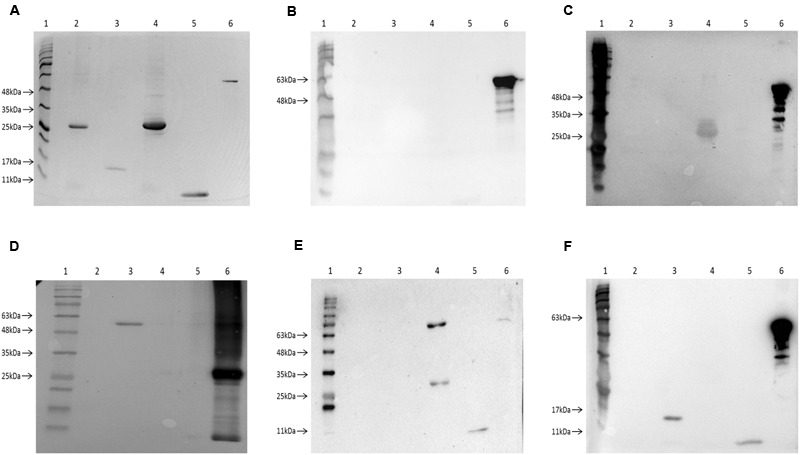
Investigation of the Exs protein interactions using Far-Western Blot. (A) A 12% SDS-PAGE gel showing the purified Exs proteins and a MBP-fused Exs protein as positive control for Far-Western Blot. Lane 1, BLUeye Prestained Protein Ladder (Geneflow); Lane 2, purified HisExsA protein (∼33 kDa); Lane 3, purified HisExsC protein (∼18.5 kDa); Lane 4, purified HisExsD protein (∼33 kDa); Lane 5, purified HisExsE protein (∼11 kDa); Lane 6, purified MBP-ExsC protein (∼61 kDa). The proteins on this SDS-PAGE gel were then transferred onto a nitrocellulose membrane for Far-Western Blot. (B) Negative control Far-Western Blot of the control protein MBP5 probing His-tagged Exs proteins. Only MBP-ExsC was observed after probing, suggesting that MBP5 protein without Exs fusions was unable to interact with His-tagged Exs proteins. (C) Far-Western Blot of MBP-ExsA probing His-tagged Exs proteins. The HisExsD protein was detected, suggesting ExsA–ExsD interaction. (D) Far-Western Blot of HisExsD probing MBP-fused Exs proteins. Only MBP-ExsC (∼61 kDa) was detected when probed with HisExsD protein. (E) Far-Western Blot of MBP-ExsC probing His-tagged Exs proteins. The HisExsD and HisExsE proteins were detected, suggesting ExsC–ExsD and ExsC–ExsE interactions. The upper band showing in lane 4 was possibly the size of a dimerized HisExsD (∼66 kDa). (F) Far-Western Blot of MBP-ExsE probing His-tagged Exs proteins. The HisExsC and HisExsE were detected when probed with MBP-ExsE, suggesting ExsE–ExsC interaction and ExsE–ExsE self-interaction.